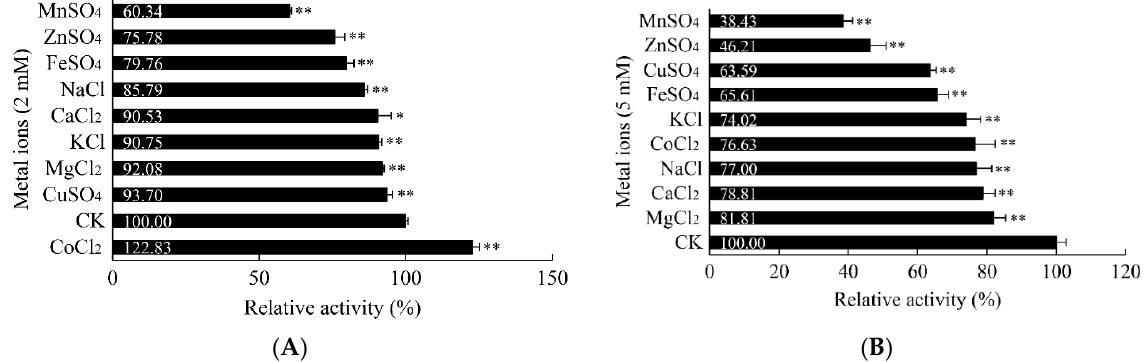
Figure 13. Influence of some metal ions on α -amylase activity. ( A ) 2 mM. ( B ) 5 mM. The purified BvAmylase activity was determined by preincubating the enzyme with different metal ions (MnSO 4 , ZnSO 4 , FeSO 4 , CuSO 4 , NaCl, CaCl 2 , KCl, MgCl 2 , CoCl 2 ) at room temperature for 30 min at 2 mM and 5 mM. The reaction activity without metal ions was taken as the control (CK), which was set to 100%. All assays were performed four times under 70 °C, pH 6.0, and 20 min. Single and double asterisks denoted the experimental groups were statistically different from the control experiment 0.01 < p < 0.05 and p < 0.01, respectively.